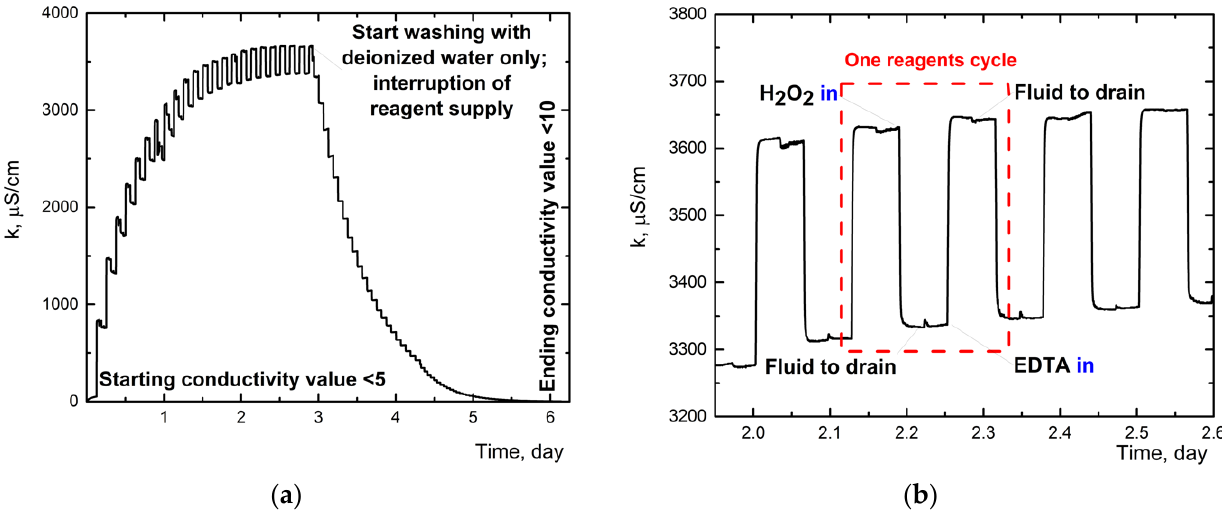
Figure 2. The profile of conductivity signal ( κ ) during the dialysis process: ( a ) overall process with the wash-out step with ultrapure water; the endpoint corresponds to the electrical conductivity lower than 10 µS/cm, signal logging every 1 s for 6 days. ( b ) Zoomed area for the plot ( a ) for the value of conductivity when filling the purification reagents (non-electrolyte H 2 O 2 decrease of κ and electrolyte EDTA increase of κ ) between 2.5 and 3